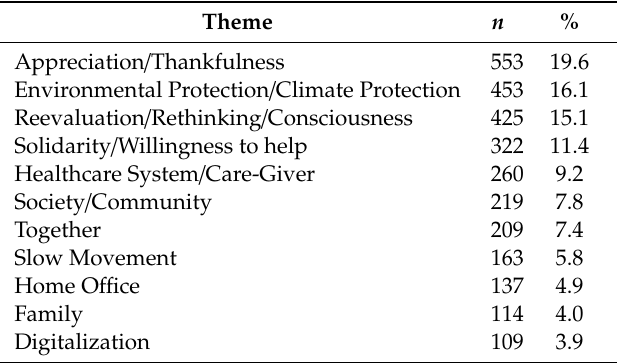
Table 6. Opportunities stemming from the COVID-19 *